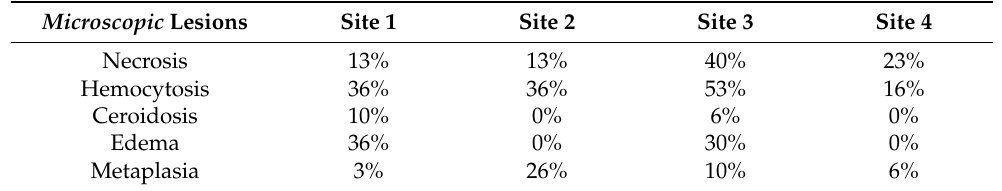
Table 2. Prevalence of microscopic lesions in different